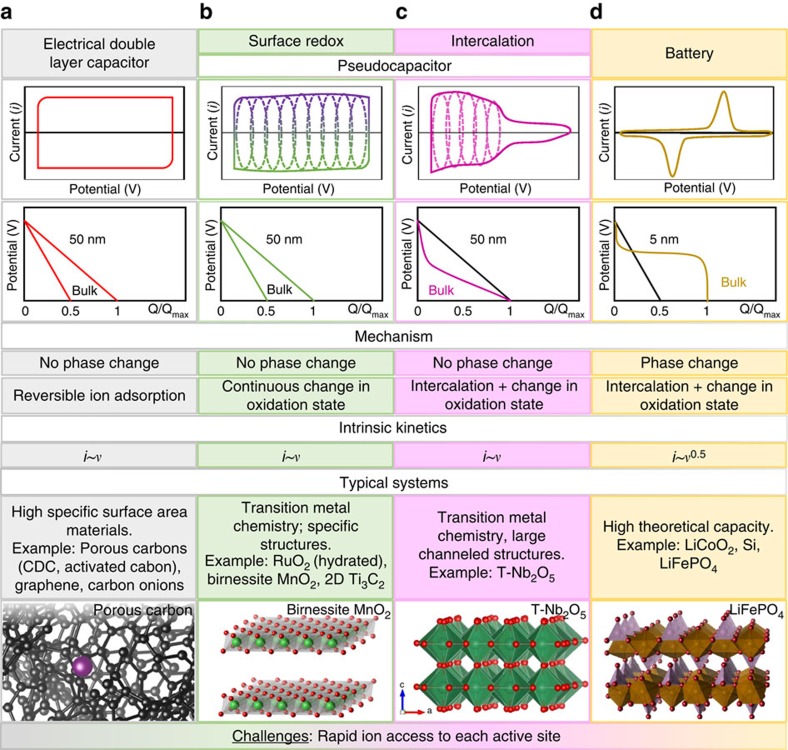
Faradaic and capacitive energy storage.Summary of the characteristic metrics such as cyclic voltammetry, galvanostatic profiles, key mechanism descriptions and typical systems that are known to utilize the mentioned charge storage mechanisms: (a) double-layer capacitor (examples: porous carbons (carbide derived carbon8, activated carbon91), graphene44, carbon onions40 and nanotubes92), (b) surface redox pseudocapacitance due to adsorption and/or fast intercalation of ions (examples: hydrated RuO2 (ref. 93), birnessite MnO2 (ref. 12), MXene Ti3C2 (ref. 15)), (c) intercalation pseudocapacitance (example: T-Nb2O5 (ref. 17)) and (d) batteries (examples: LiCoO2 (ref. 94), Si37, LiFePO4 (ref. 1)). i=current, v=sweep rate. Crystal structures were plotted in Vesta. Different colours in the plots indicate different storage mechanisms.